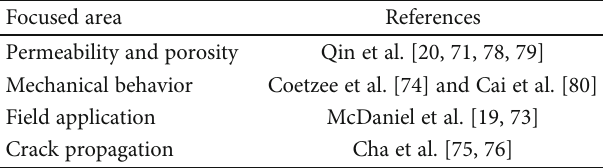
Figure 14: Schematic diagram for the coal seam after cryogenic liquid nitrogen stimulation [72]. Table 1: Focused areas of di ff erent studies.